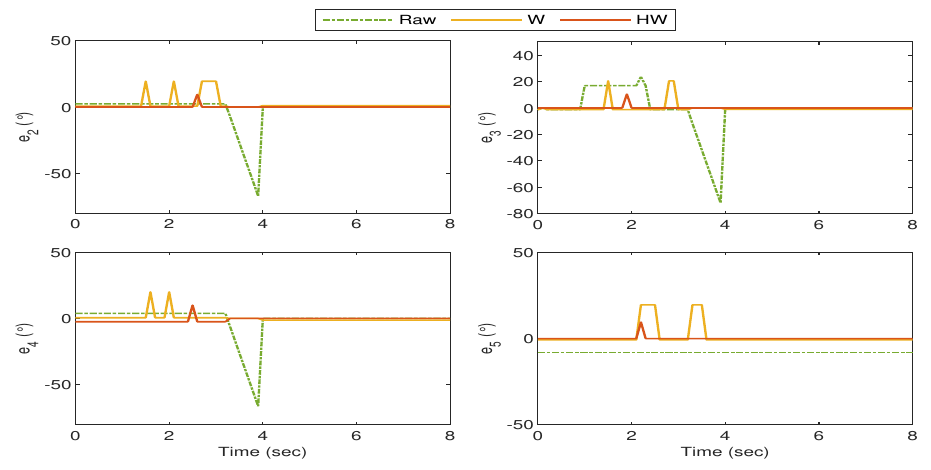
Figure 19. Gesture 3: The corresponding error from the response in Figure 18. The error due to the response from Compensator HW is the least at all time instances as compared to the